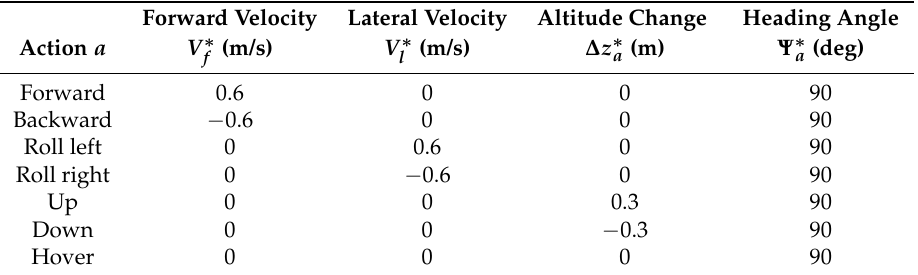
Table 1. Summary of actions in navigation and target finding